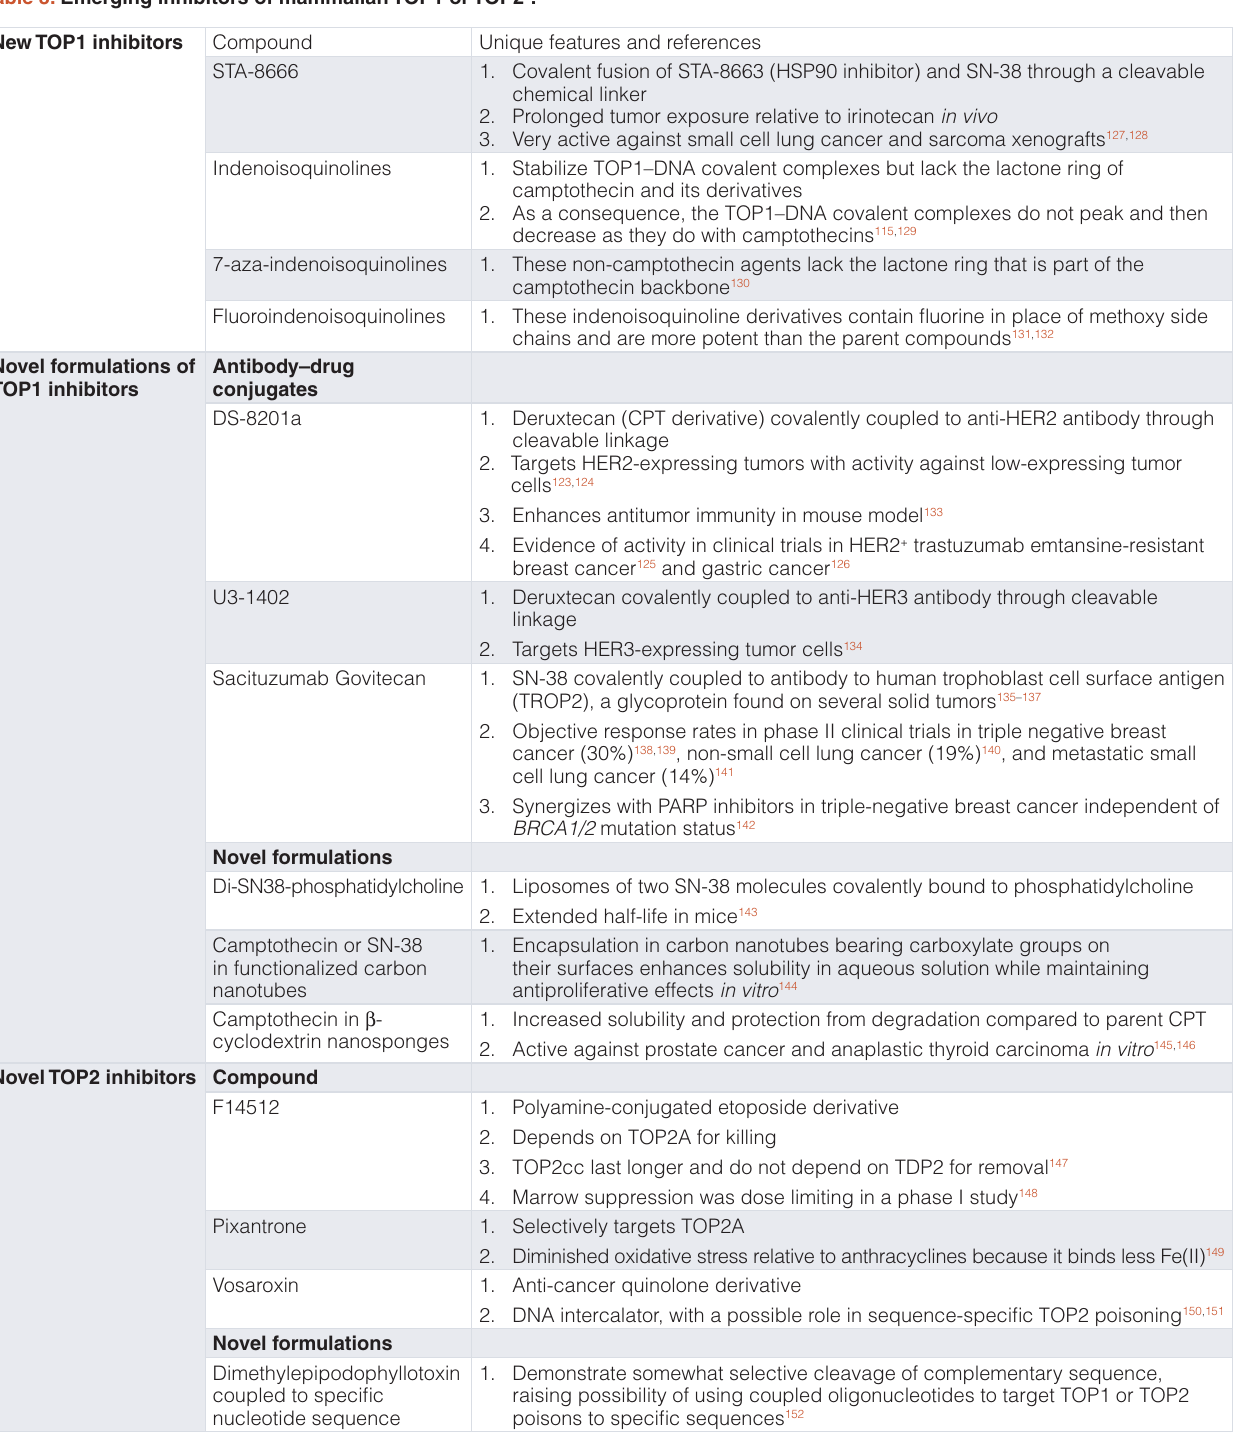
Table 3. Emerging inhibitors of mammalian TOP1 or TOP2 a